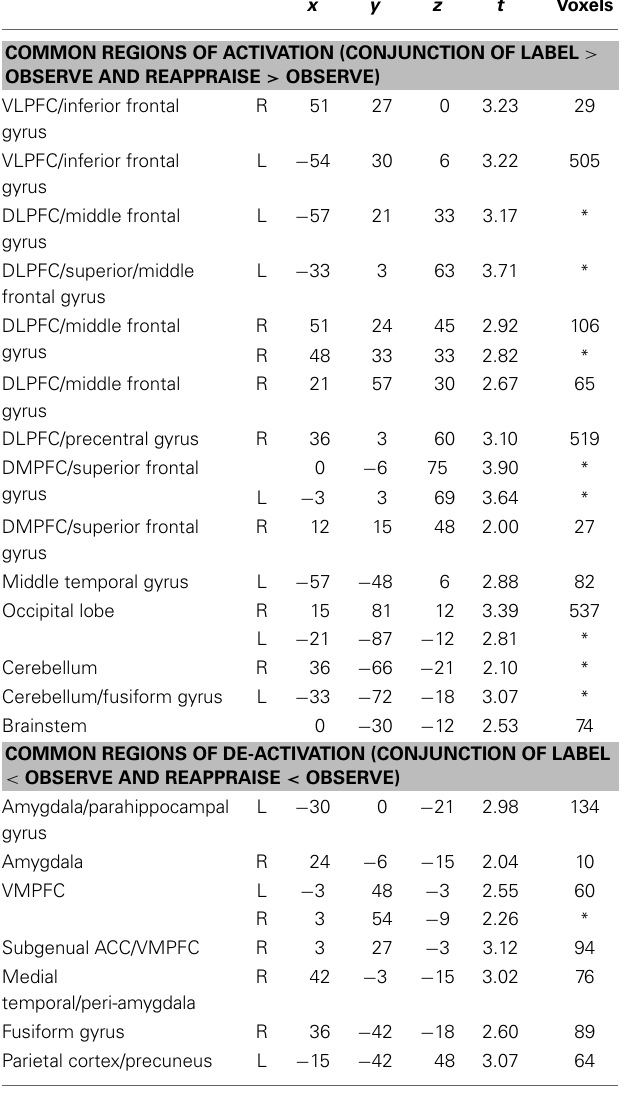
Table 1 | Common activations for Labeling and Reappraisal relative to Observe-only. x y z t Voxels